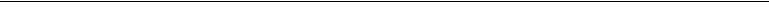
Figure 1 | Inhibitory effects of AIL on AR activity and PCa cell proliferation. ( a , b ) PCa cells were treated with different concentrations of AIL for 12h and luciferase activities were measured. MMTV-luc reporter was stimulated by DHT ( a ) or exogenous AR 1–651 ( b ). ( c ) LNCaP cells were cultured in 5% c-FBS for 5 days and treated with 10nM R1881 alone or 0.2 m M AIL with 10nM R1881 for 12h. The gene expression was measured by quantitative-PCR. ( d ) PC3 cells were transfected with AR 1–651 , MMTV-luc, Renilla-luc and treated with indicated concentrations of bicalutamide (BIC), MDV3100 (MDV) and AIL. After 12h, the MMTV-luc activities were detected (left panel). 22RV1 cells were stimulated with or without 10nM R1881 and treated with 10 m M MDV or 0.2 m M AIL. After 12h, total RNA was extracted and PSA mRNA was measured by quantitative-PCR (right panel). ( e , f ) The AR negative cell lines PC3 and DU145 (AR (cid:2) ), normal prostate cell lines RWPE-1 and WPMY-1 (N), and AR positive cell lines LNCaP, 22RV1, LAPC4 c4-2b,VcaP and cell lines PC3 and DU145, and positive cell lines LNCaP, 22RV1 were treated with 0 or 0.1 m M AIL for 7 days, and the cell colonies were counted ( f